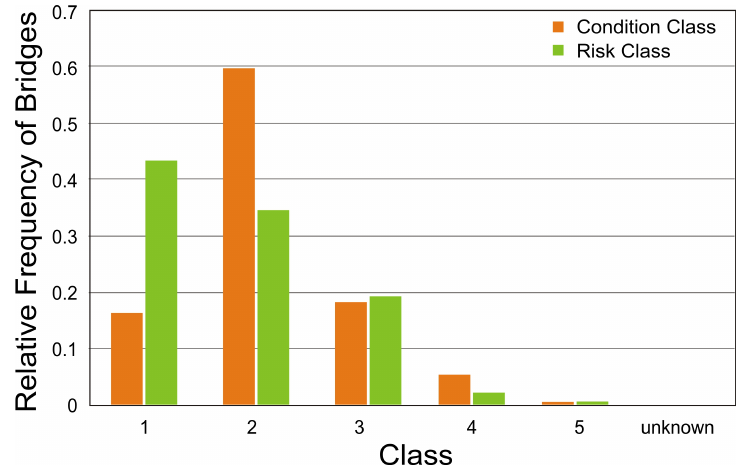
Figure 8. Comparison of the frequency of bridges in the condition and risk classes (class 1 means either good condition or low risk, class 5 means very bad condition or very high